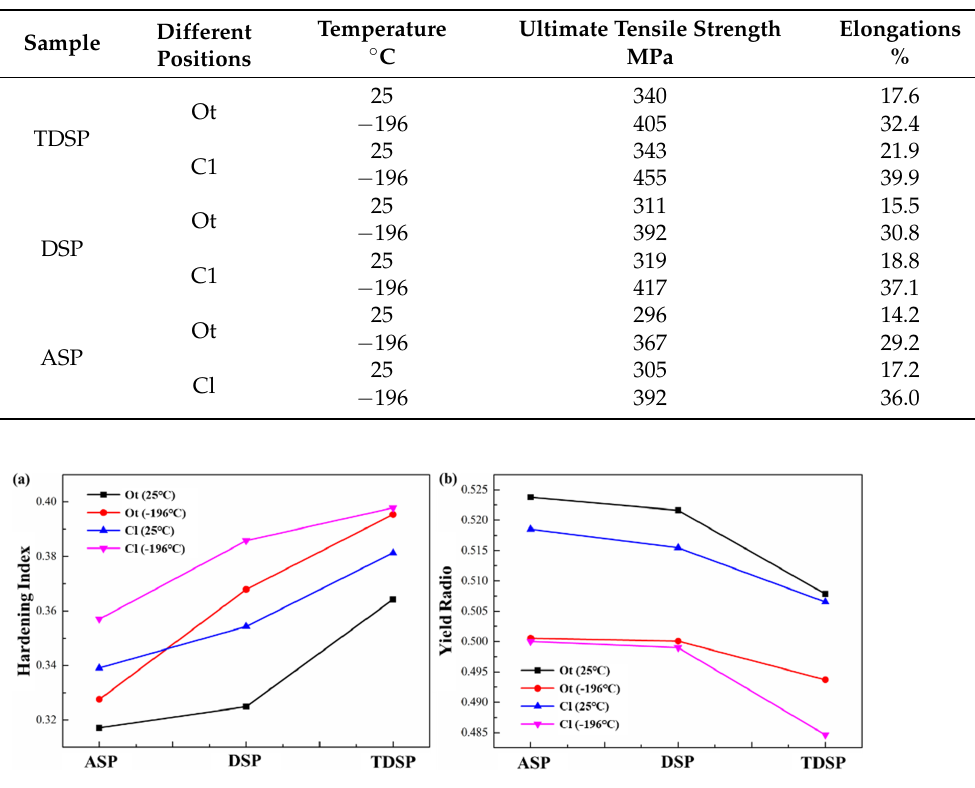
Figure 5. The n values and yield-strength ratios of the Ot and Cl samples of three different plates at different temperatures: ( a ) 25 °C; ( b ) − 196 °C.